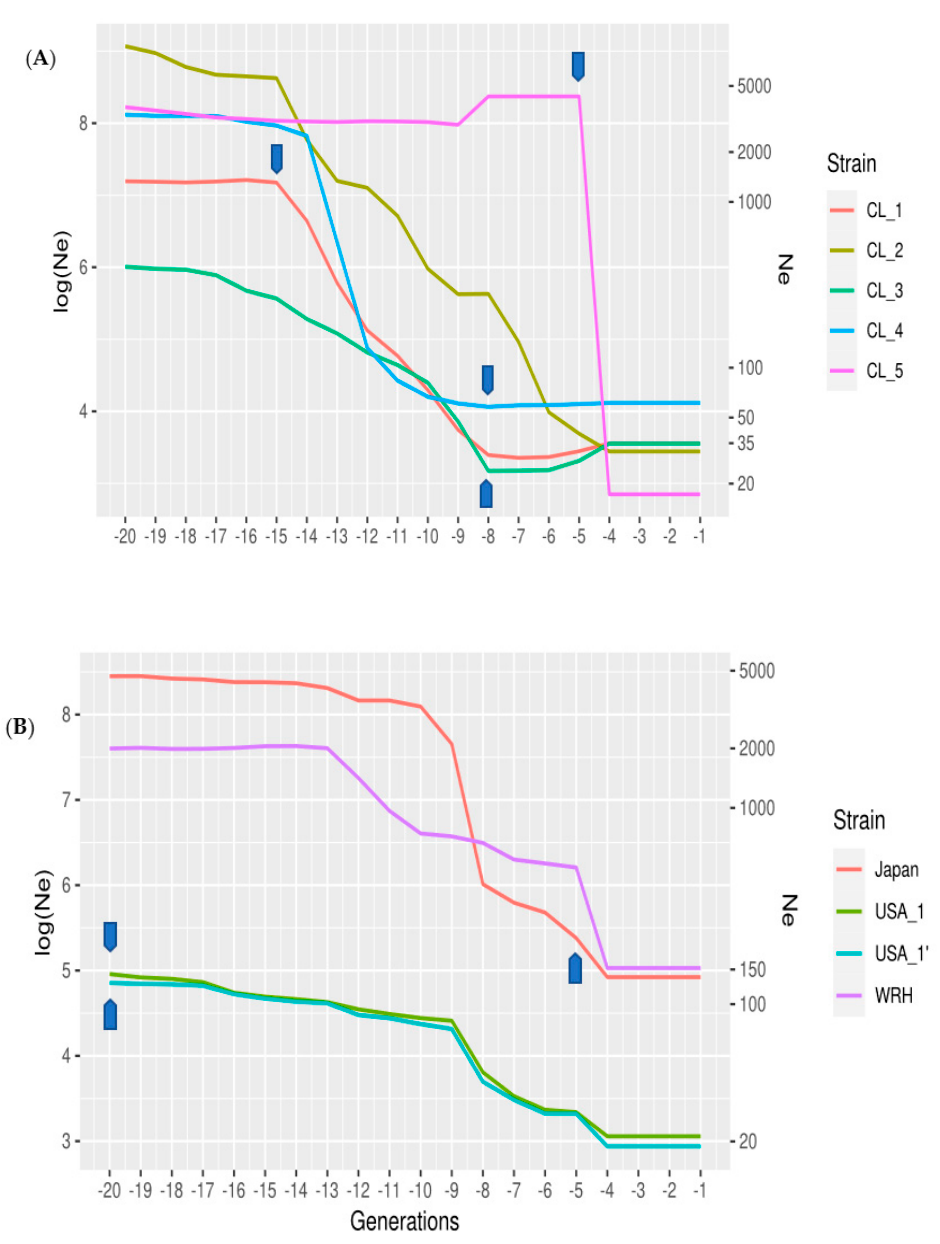
Figure 2. Estimates of the effective population size (Ne) on a logarithmic scale (log), second Y axis actual Ne) within the last twenty generations, reflecting the time over which different strains were established. Each strain was analyzed using the methods of [25]: ( A ) Chilean strains, and ( B ) North American strains and Japanese strains. Arrows (Blue) denote the most likely generation when the breeding program was started (Table S1).